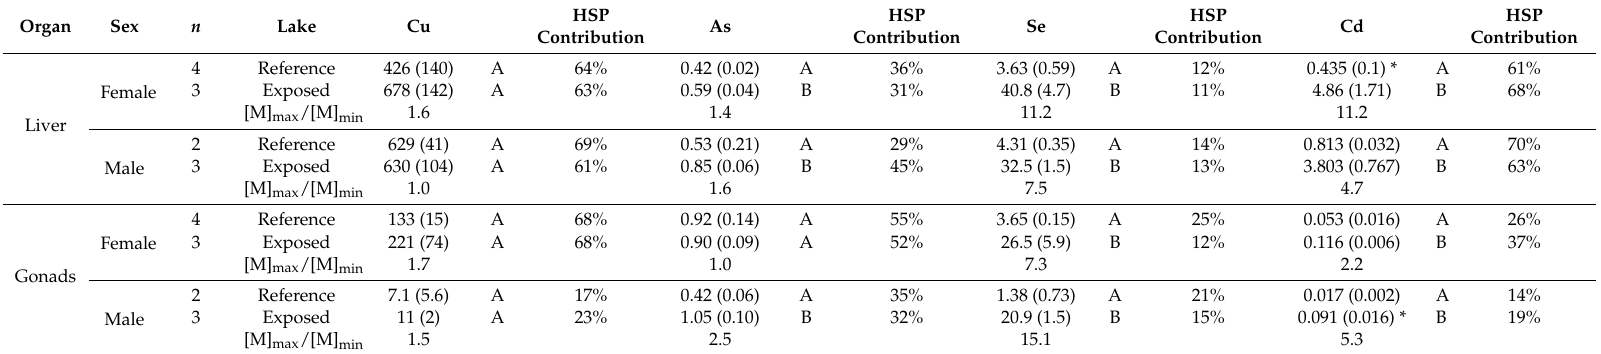
Table 2. Trace element concentrations (nmol/g dw, mean (standard error)) in hepatic and gonadal HSP (heat-stable proteins or peptides) fractions of white suckers collected in summer 2016 and mean relative contribution of the HSP fraction to the total metal/metalloid burden in liver and both gonad